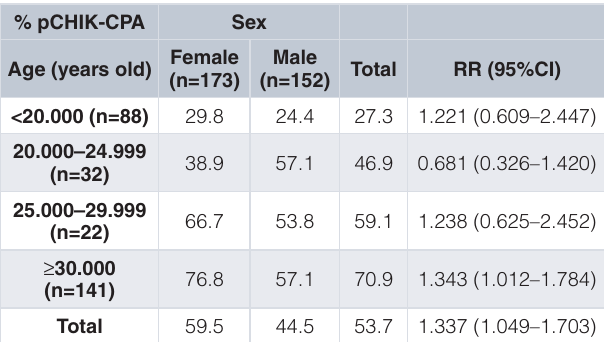
Table 1. Prevalence of pCHIK-CPA in a cohort of La Virginia, Risaralda, Colombia; overall, by gender, and by age